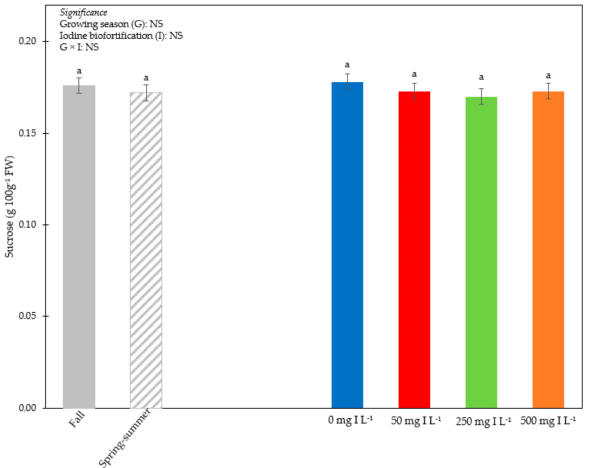
Figure 6. Effect of the growing season (fall or spring–summer) and iodine supply (0, 50, 250 or 500 mg L − 1 ) on sucrose concentration in curly endive. Different letters indicate significant differences at p ≤ 0.05. NS,